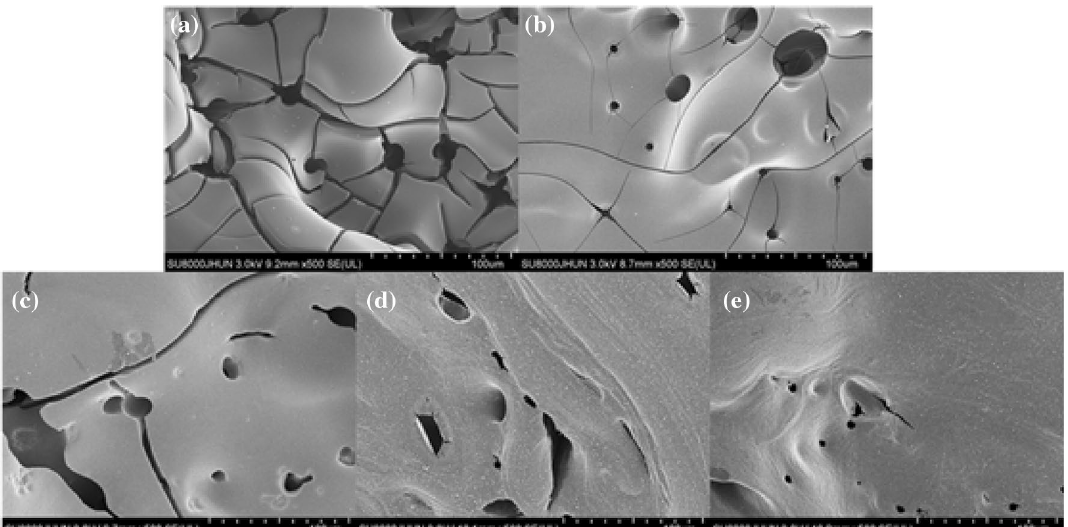
Figure 6. SEM micrographs ( a neat epoxy resin, b 5DOPO-CuPc/EP, c 10DOPO-CuPc/EP, d 15DOPO-CuPc/ EP, e 20DOPO-CuPc/EP) of residue chars of epoxy thermosets after cone